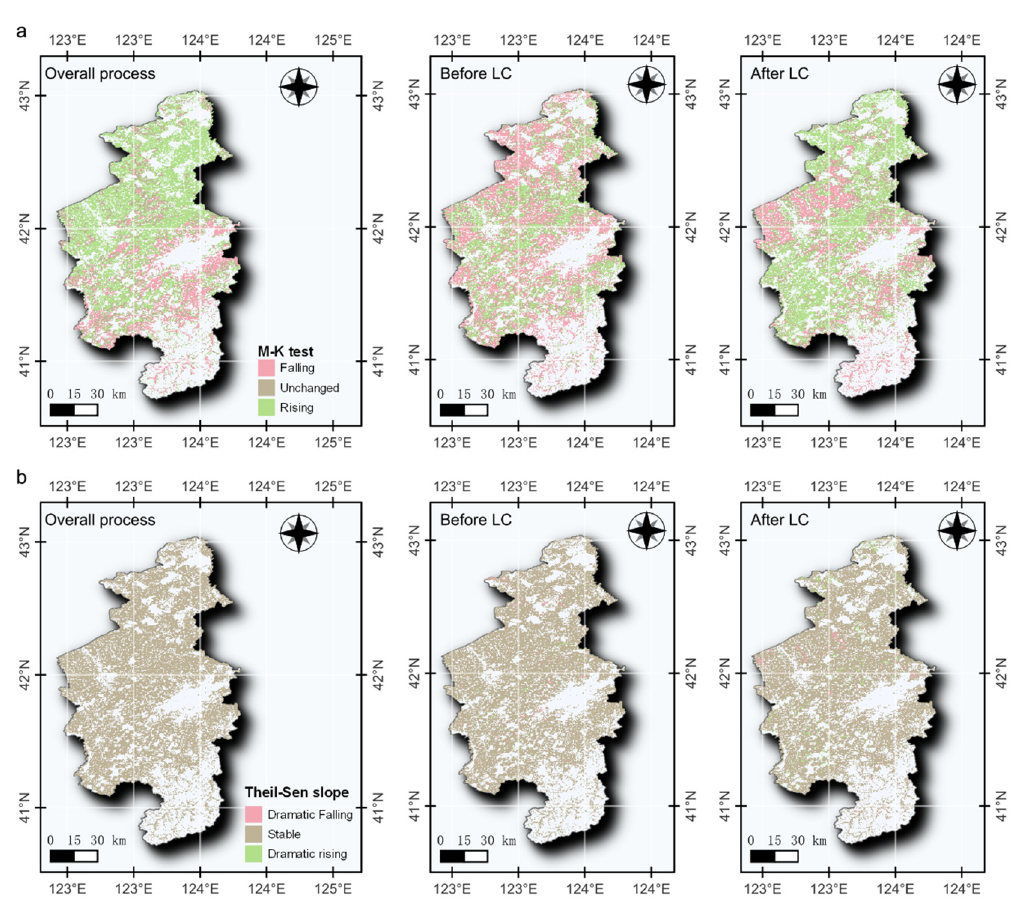
Figure A3. Results of trend analysis for the farmland without FC: ( a ) M–K test; ( b ) Theil–Sen Slope test.